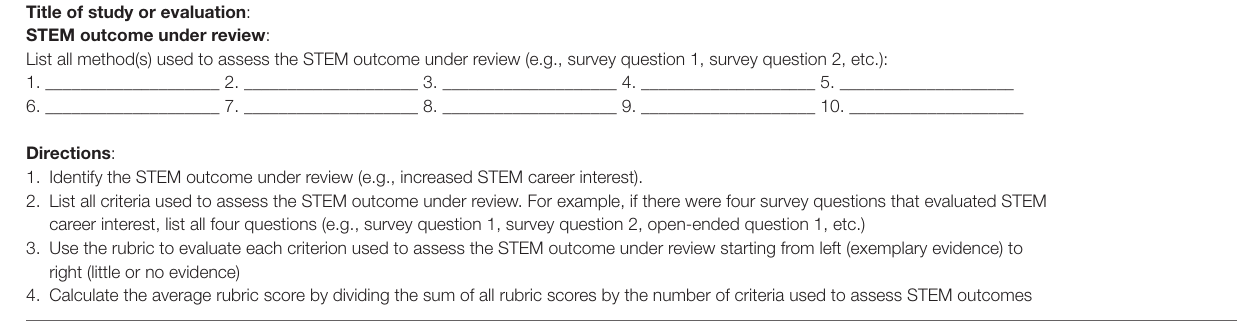
TABLE 7 | STEM impact rubric for mixed methods studies. Title of study or evaluation : STEM outcome under review : List all method(s) used to assess the STEM outcome under review (e.g., survey question 1, survey question 2, etc.): 1. ____________________ 2. ____________________ 3. ____________________ 4. ____________________ 5. ____________________ 6. ____________________ 7. ____________________ 8. ____________________ 9. ____________________ 10.